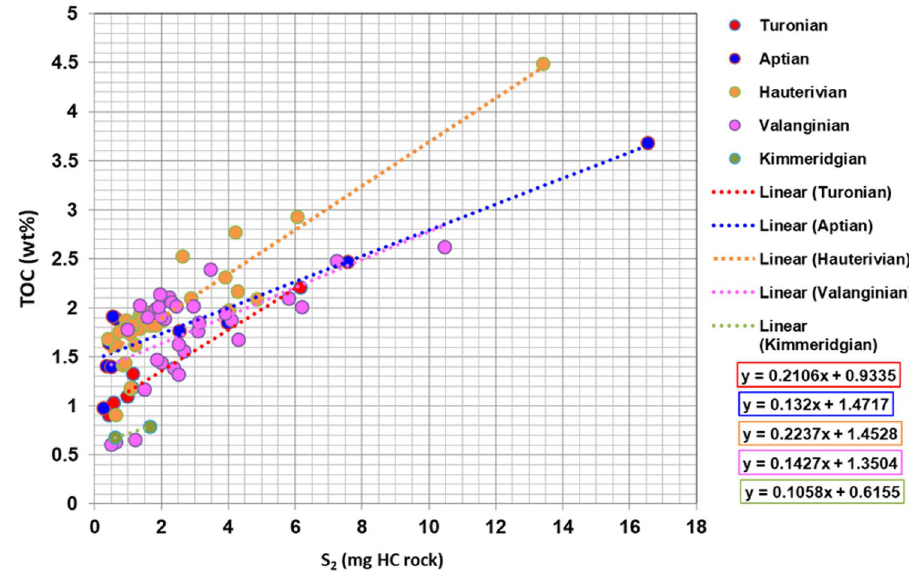
Fig. 4 A plot of S 2 versus TOC for the studied source rocks in Block 11a